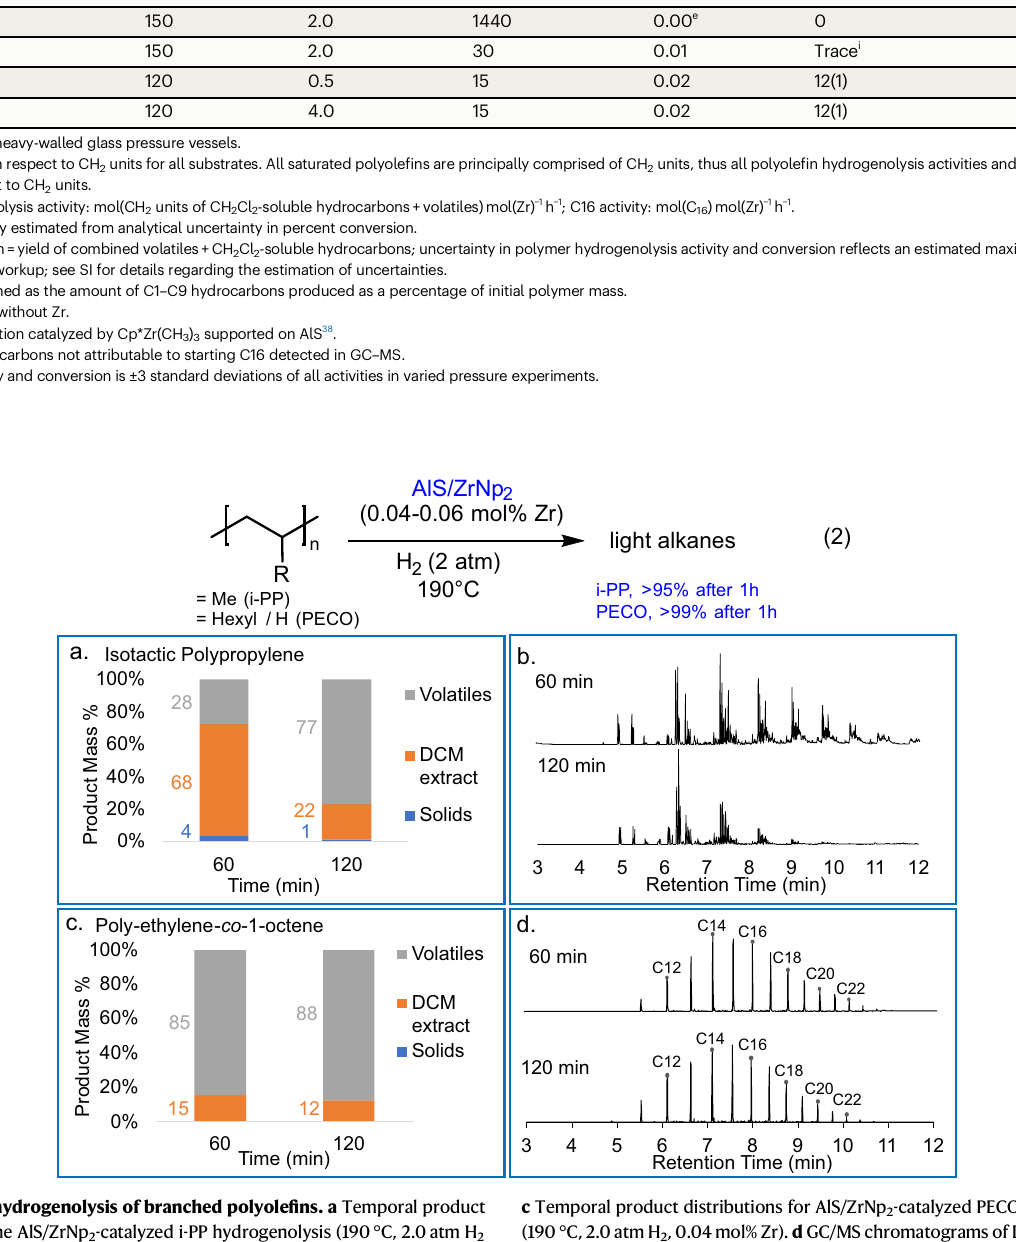
c Temporal product distributions for AlS/ZrNp 2 -catalyzed PECO hydrogenolysis